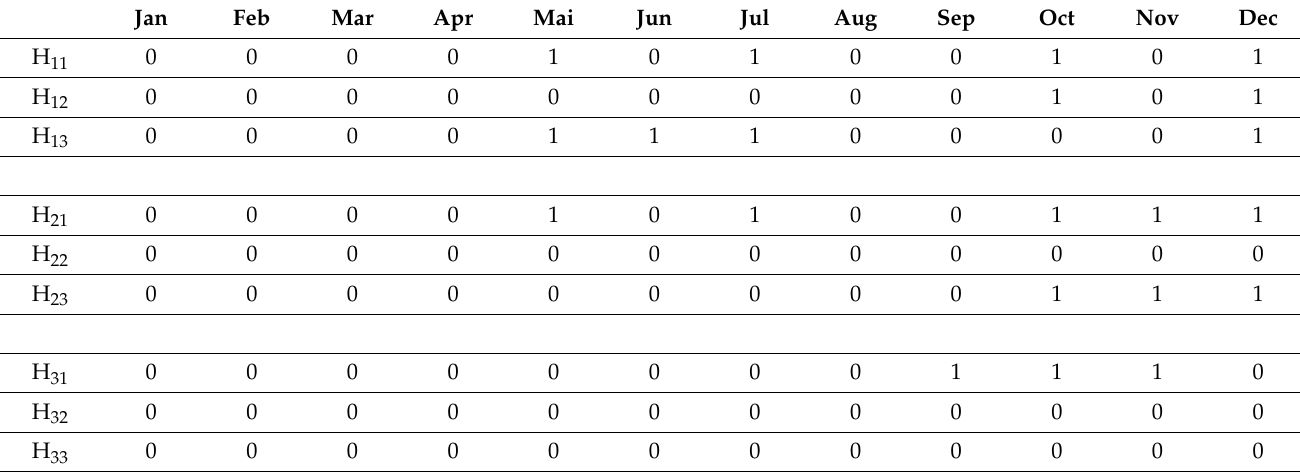
Table 1. Summary of the results of the statistical analysis. (Source: own